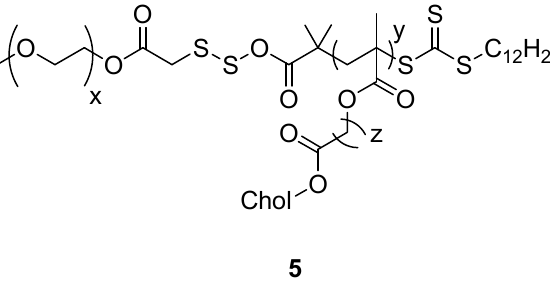
Figure 3. Structure of cholesterol-based block copolymer with disulfide linkage ( 5 ).